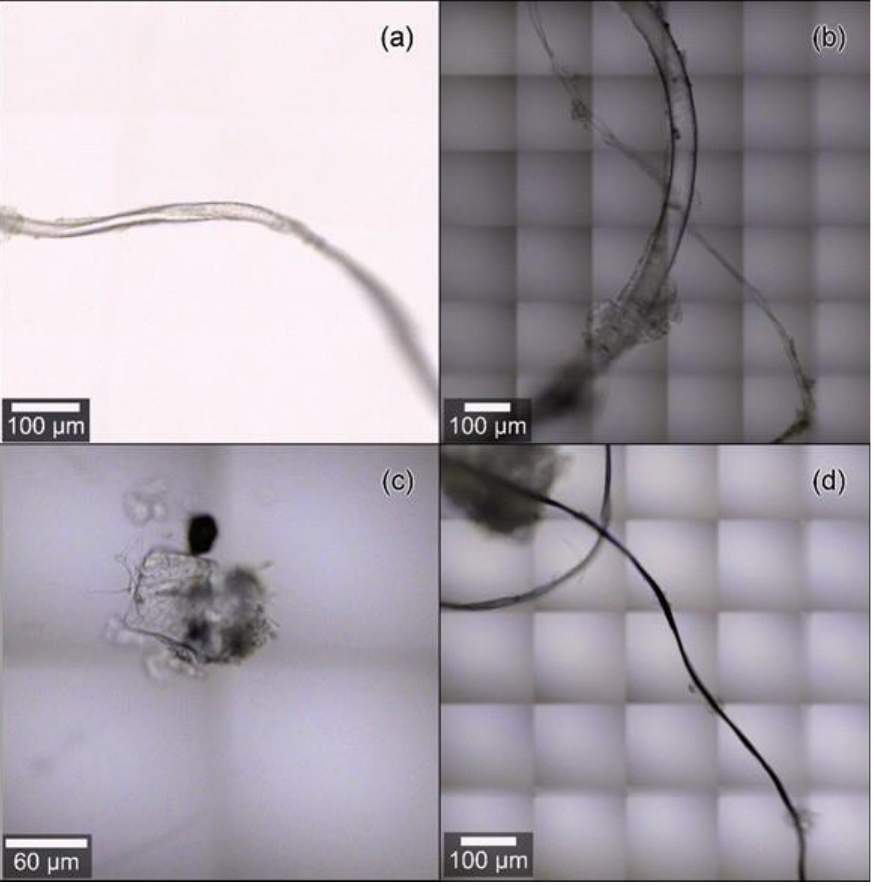
Figure 6. Optical micrographs of selected microplastics analysed by Raman spectroscopy: ( a ) clear fibre, ( b ) clear fibre, ( c ) clear fragment, and ( d ) black fibre.